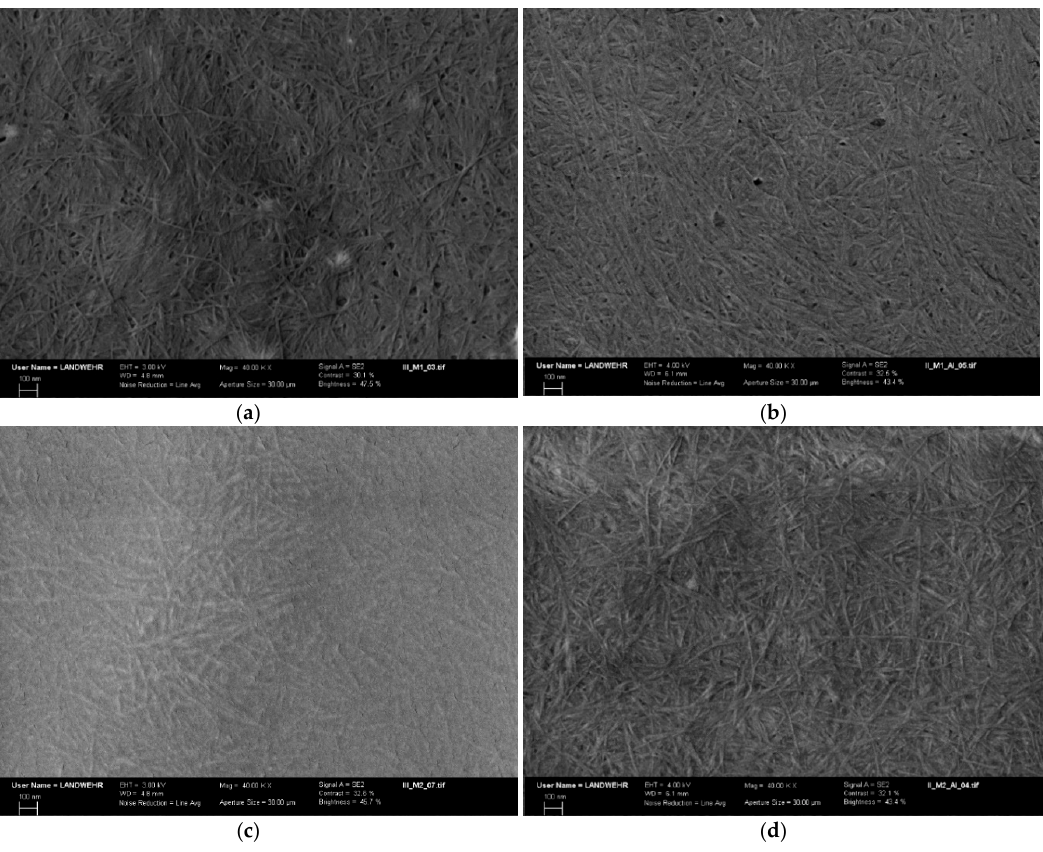
Figure 11. SEM images of ( a ) A β (1–16) A 36,13,14 ; ( b ) A β (1–16) A 36,13,14 + Al 3+ ; ( c ) A β (1–16) S 36,13,14 ; ( d ) A β (1–16) S 36,13,14 + Al 3+ (mag: 40 KX, aperture size: 30 μ